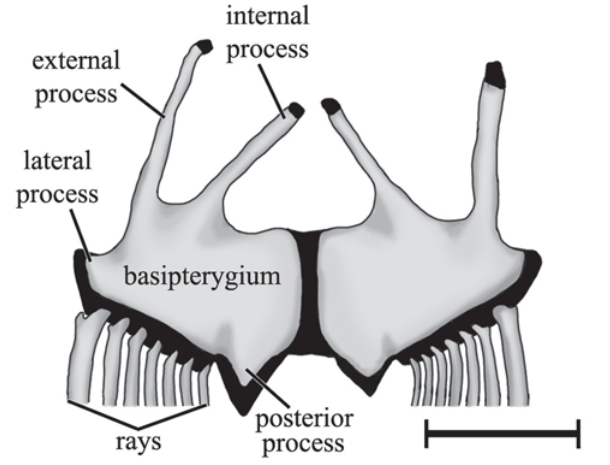
Fig. 7. Schematic illustration of the pelvic girdle in dorsal view of Liosomadoras oncinus , based on MZUSP 105828, 101 mm SL. Scale bar = 5 mm.